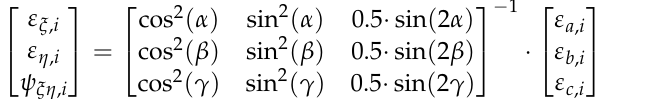
Figure 5. Top view of the cross-section marking the positions of the three strain rosettes as red dots together with the global coordinate system with coordinates ( x , y , z ) and local the coordinate systems with coordinates ( ξ i , η i ) , i = 1,2, 3. The local η i -axis points in the same direction as the global x -axis.